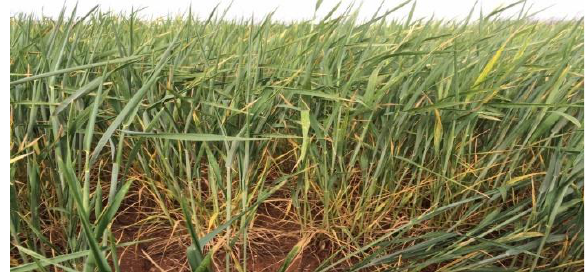
Figure 2: Impacts of drought on leaf (Source: Agrilife,